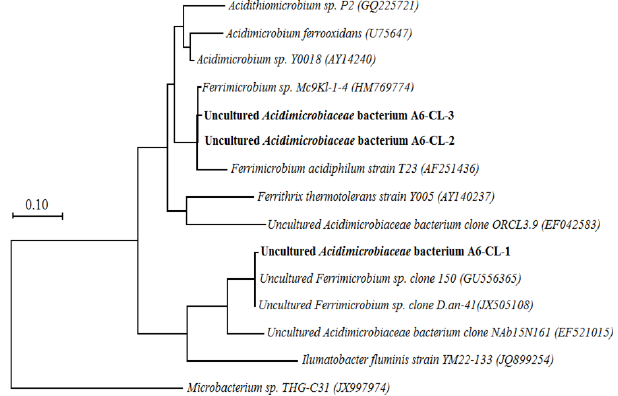
Figure 5. Phylogenetic tree of Acidimicrobiaceae -related se- quences. The tree was constructed using the Bayesian inference (BI) method with 16S rRNA gene sequences from DGGE band A6 and bacteria from the Acidimicrobiaceae family from other studies. Sequences determined in this study are in bold. Bootstrap values were based on 1000 replicates each and are shown at the nodes with less than 50% bootstrap support. The scale bar represents 10% se- quence divergence.